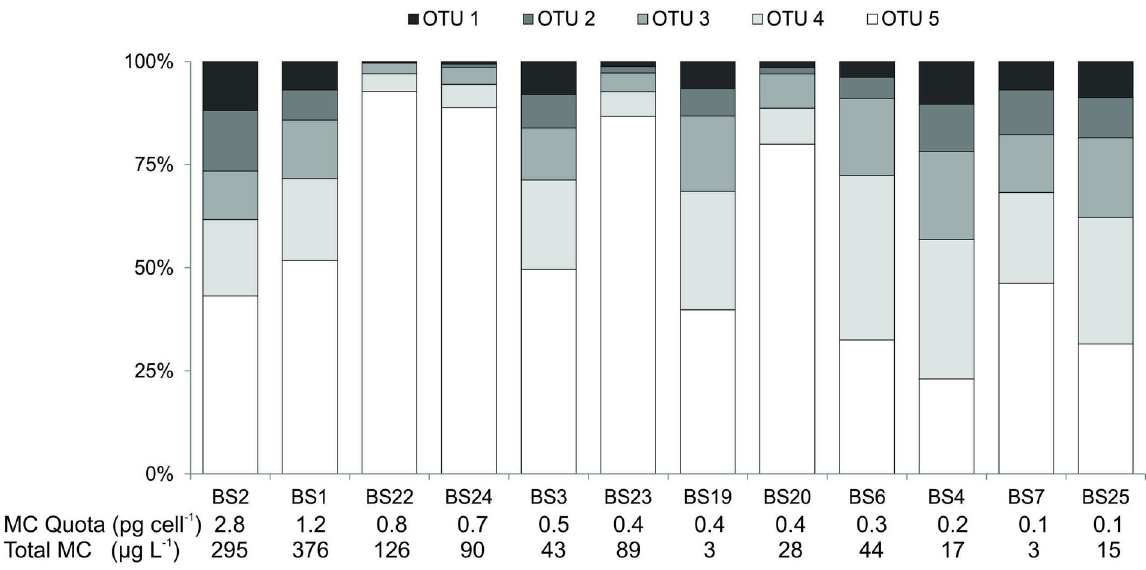
Fig 3. Stacked column graph representing the relative distribution of different operational taxonomic units (OTUs) from Microcystis intergenic spacer regions in twelve samples from the bay study (see Fig 1c for location of samples) ordered by decreasing microcystin